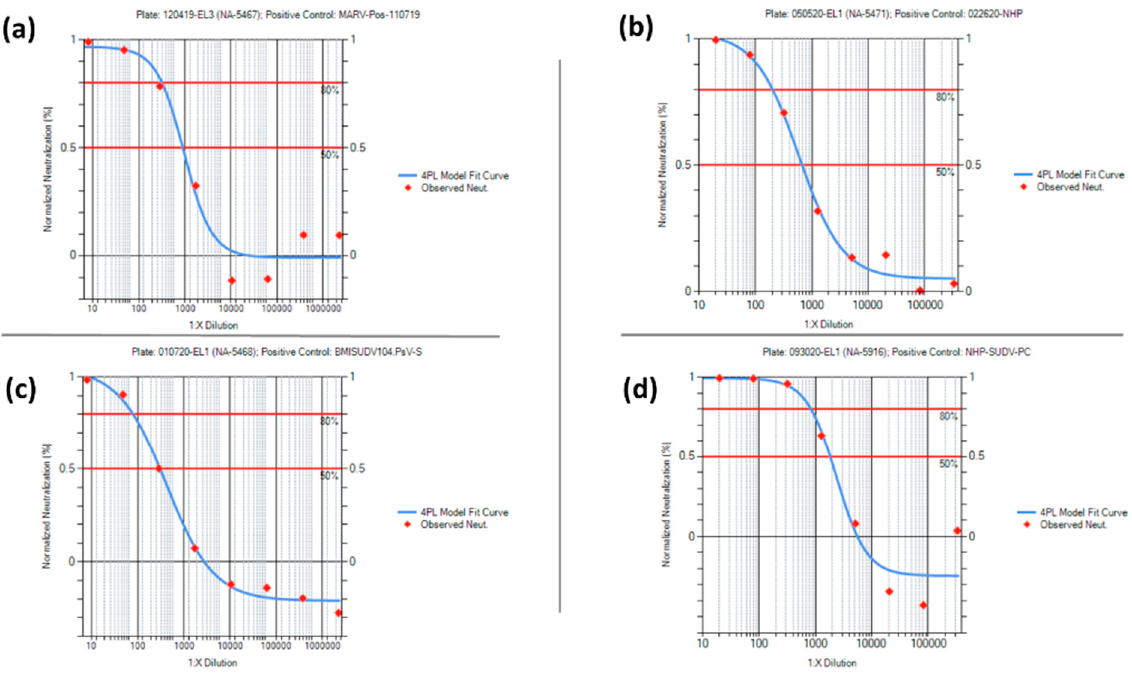
Figure 11. Neutralization Data from Positive Controls. ( a ) MARV and human; ( b ) MARV and NHP; ( c ) SUDV and human; ( d ) SUDV and NHP.